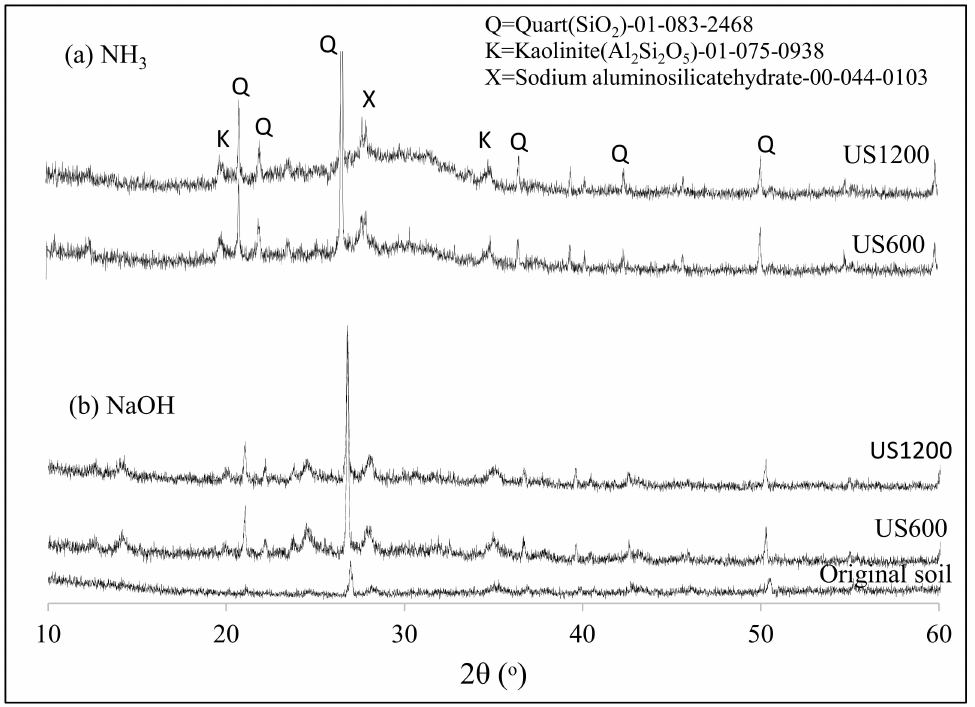
Figure 9. XRD patterns of original soil and soil after geopolymerization under di ff erent ultrasound power, ( a ) NH3, ( b )